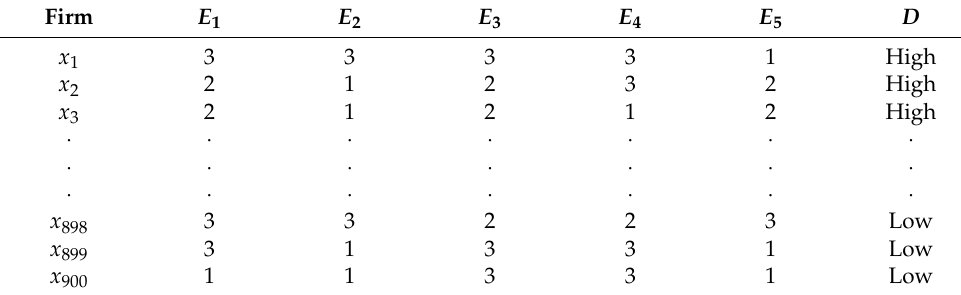
Table 2. Evaluation form of the company’s venture capital.